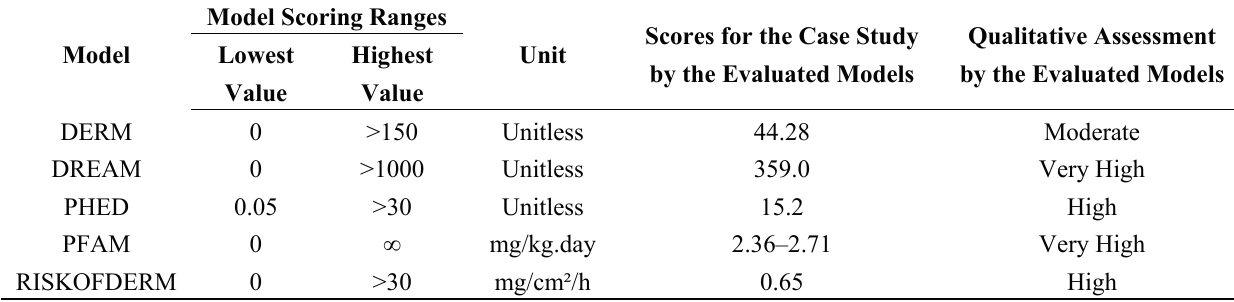
Table 5. Actual dermal exposure assessments by the selected models for the study area.